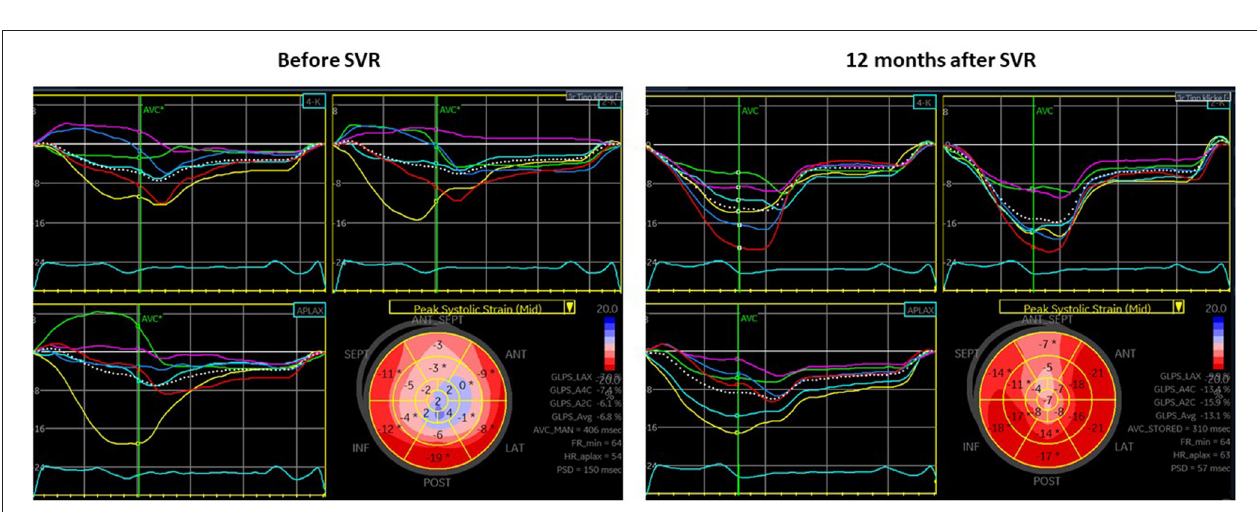
FIGURE 3 | Echocardiography before surgical ventricular restoration (SVR) (left panel) and at the short-term follow-up (right panel) in a patient (65 years old, male) with end-systolic basal longitudinal strain (BLS) (-6.8%) and intermediate LV shape before SVR [without patch, no concomitant coronary artery bypass graft (CABG), or valve surgery]. At 12 months after SVR, there is a valuable improvement in EF (from 30 to 47%) and end-systolic global longitudinal strain (GLS) (from − 6.8 to − 13.1%), a decrease in LV end-diastolic volume (LVEDV) (from 226 to 124ml) and LV end-systolic volume (LVESV) (from 159 to 66ml) as well as decrease in mechanical dispersion (150 to 57ms).